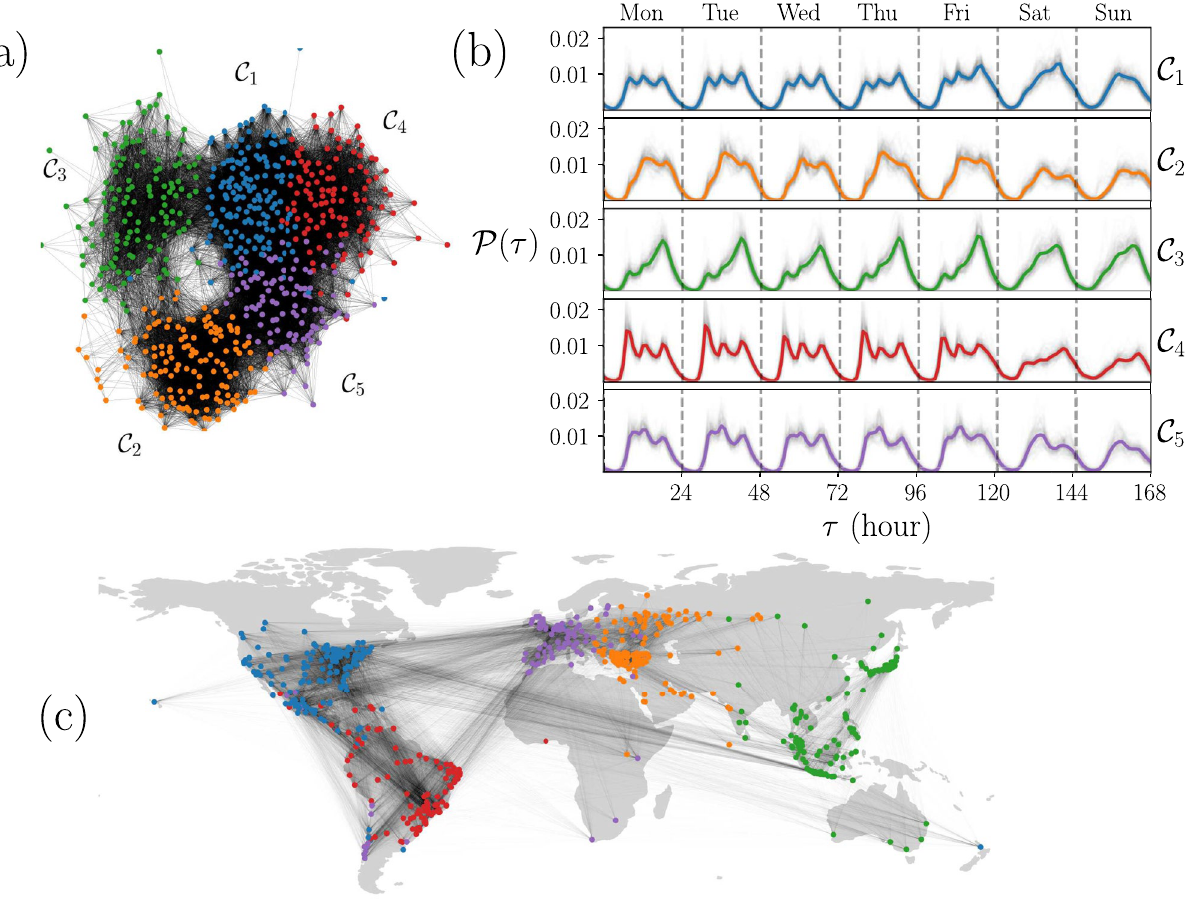
Figure 6. Human activity patterns identified using community detection in similarity networks. ( a ) Community structure of the similarity network generated with H = 0.0723 , five communities C 1 , C 2 , C 3 , C 4 , C 5 were detected using the Louvain’s algorithm and are represented with different colors. ( b ) Probability for the temporal activity of the cities in each community. Thin gray lines present the curves P i (τ) depicted in Fig. 3a whereas the colored thick line represents the statistical analysis of all the check-ins in the cities of the community. ( c ) Geographical representation of the network in ( a ). In this case, each node is a city depicted on a world map. All figures were created using python 3.8 and the matplotlib (3.5.0) package (https:// matpl otlib. org). The map in panel ( c ) was created using the geopandas (0.12.1) package (https:// geopa ndas.